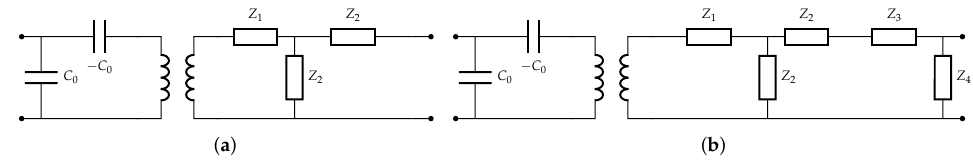
Figure 1. Mason’s model: ( a ) unloaded case and ( b ) loaded